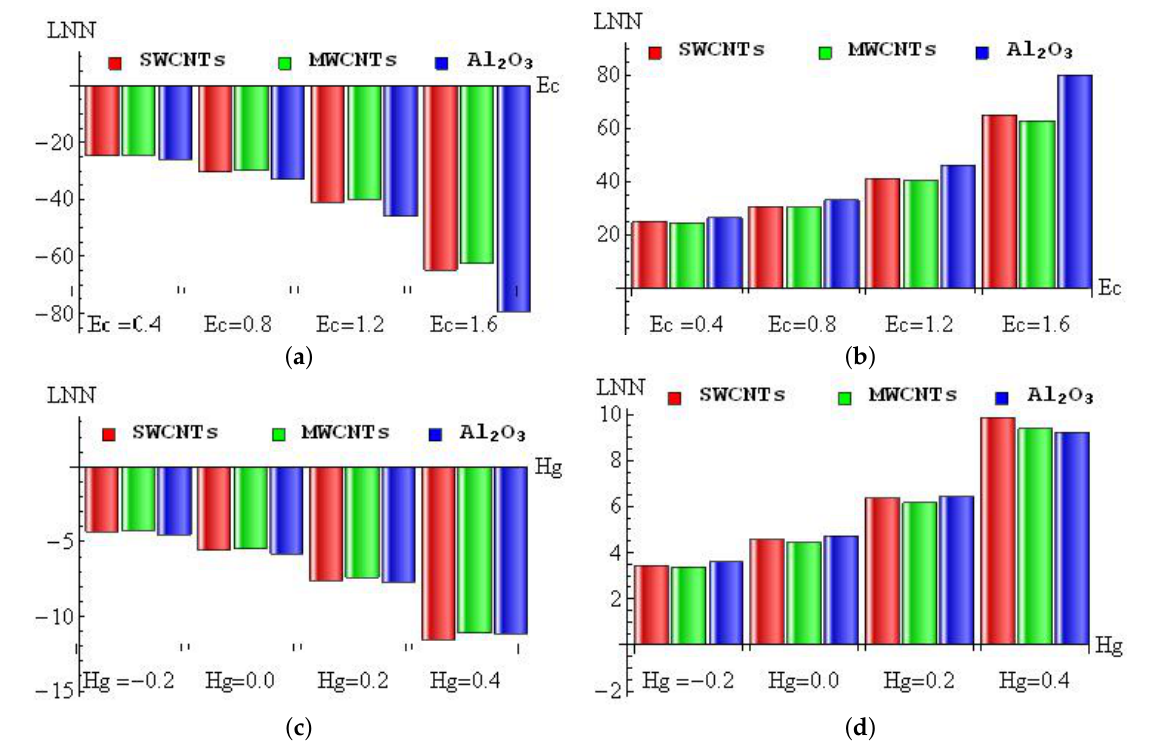
Figure 13. The diminishing/improving percentage of LNN for Ec ( a , b ) and Hg ( c , d ) with convective heating ( a , c ) and convective cooling ( b , d )